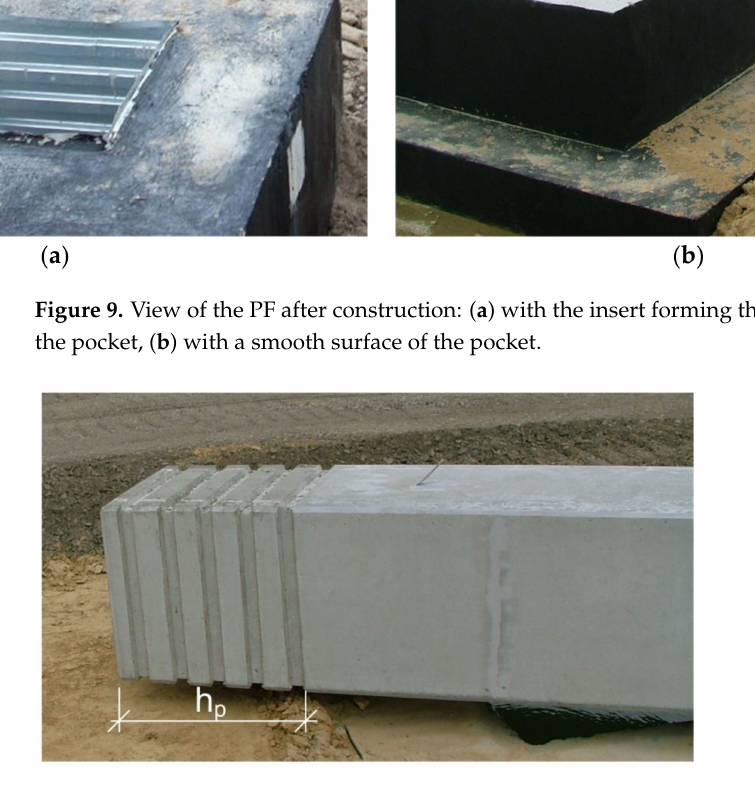
Figure 10. View of the end of a precast column with a keyed-shaped surface; h p , description in the